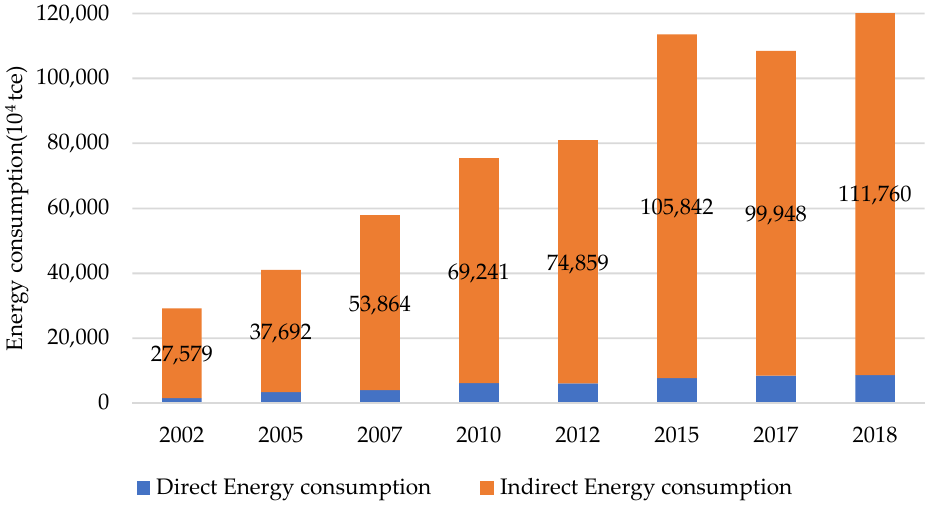
Figure 1. The direct and indirect energy consumptions of the Chinese construction sector in 2002– 2018.